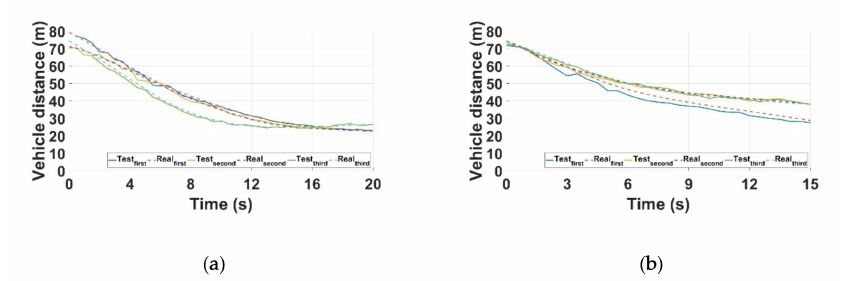
Figure 16. Comparison of theoretical values and real vehicle test results based on distance to the center of the lane: ( a ) scenario 11 and ( b ) scenario 12.